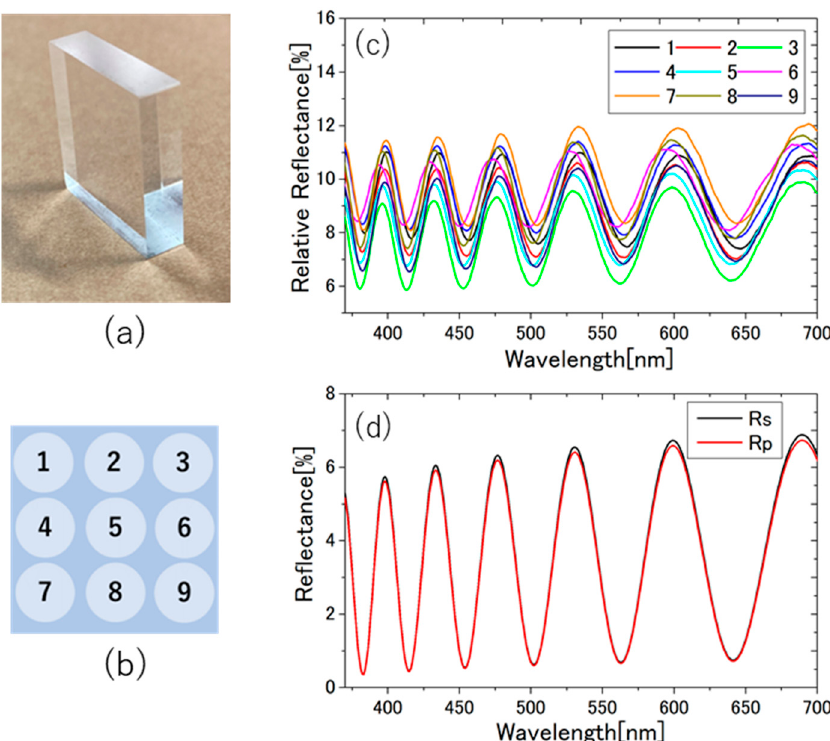
Figure 4. ( a ) The photo of the PVP coated MgF 2 substrate. At nine positions in ( b ), the reflectance relative to aluminum mirror was measured at an incidence angle of 5 ◦ in air using a spectrophotometer (SolidSpec-3700 DUV, Shimadzu, Kyoto, Japan) as shown in ( c ). The position dependent variation of the interference fringe patterns was not significant. The film thickness was determined to be 1480 nm by comparing the experimental results ( c ) with the calculated result ( d ) using Equation (1).